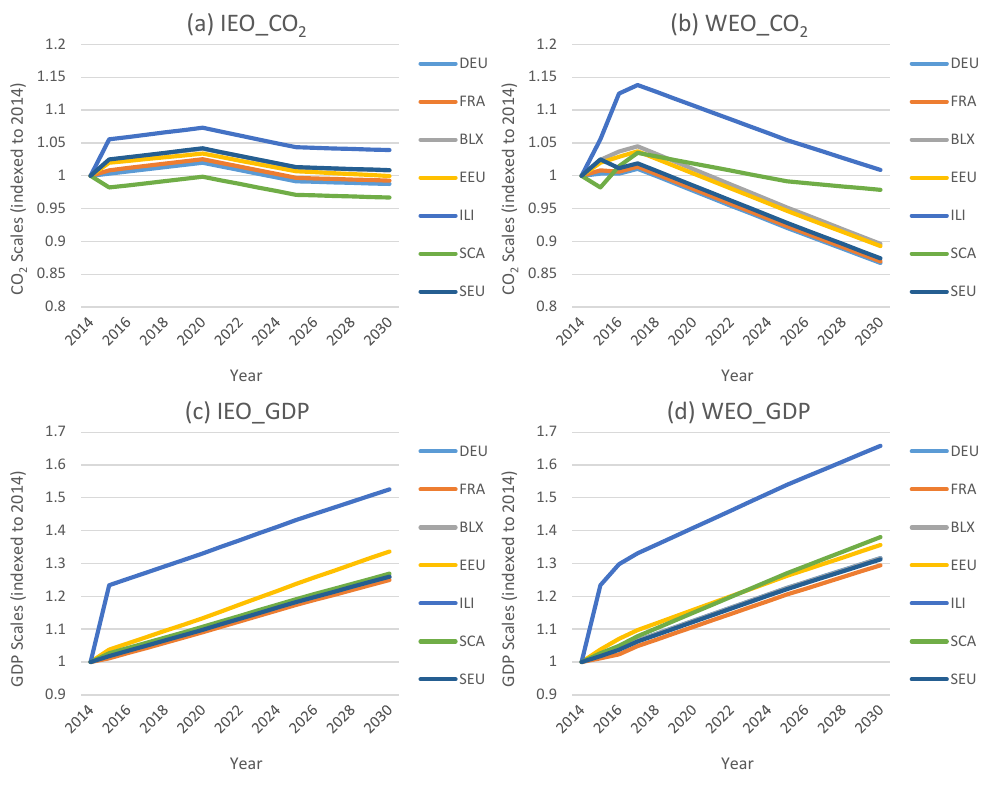
Figure 3. CO 2 scales and GDP scales for the IEO and WEO baselines in 2014–2030 (used for